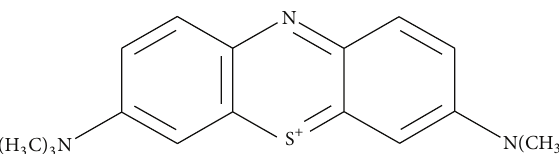
Figure 1: The chemical structure of methylene blue (drawn with Symyx Draw).